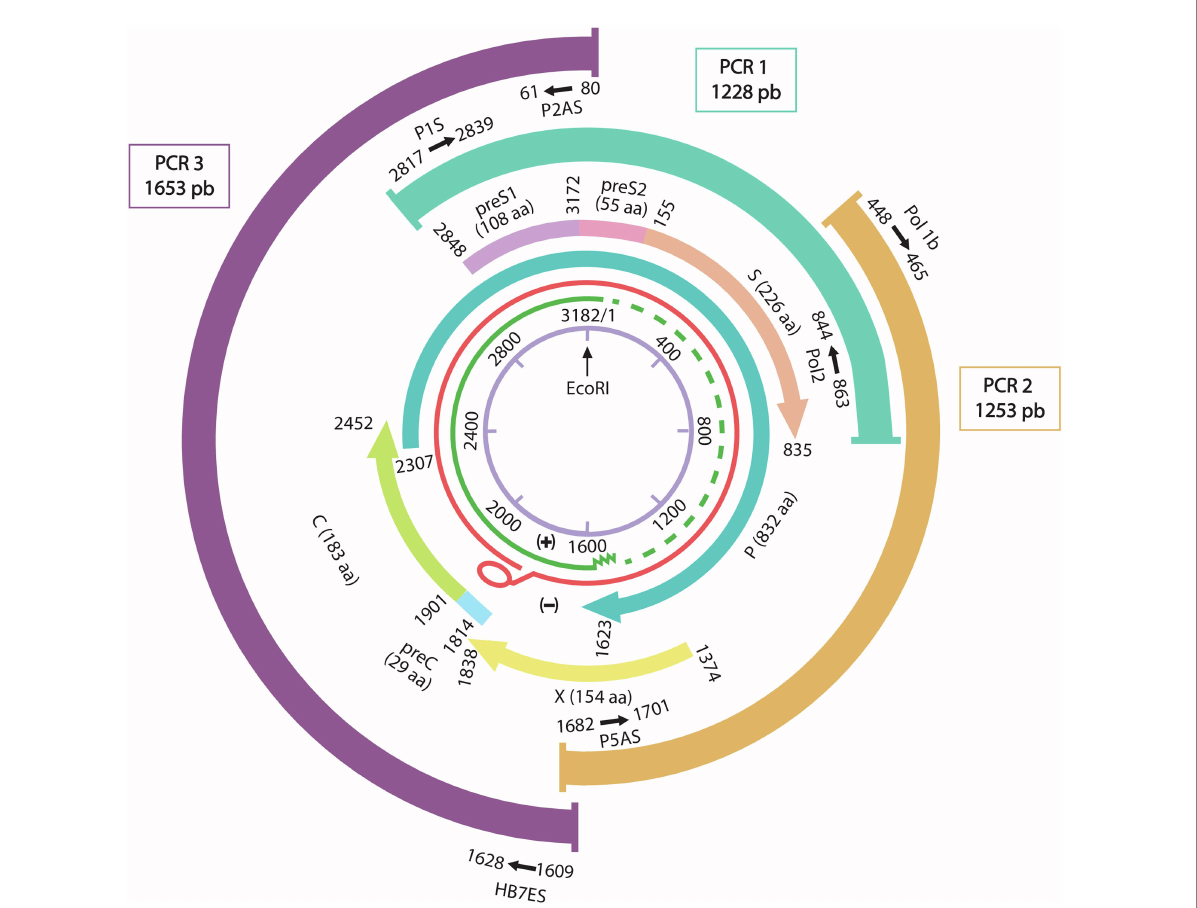
FIGURE 1 Representation of the HBV whole genome with the three overlapping PCR products and their primers sets positions. From inside to outside: schematic representation of the HBV genome with the EcoR1 restriction enzyme site representing nucleotide number 1. In green the incomplete positive strand, in Red the complete negative strand of the HBV genome. The overlapping genes P: Polymerase gene, S: Surface gene, C: capsid gene and X gene. Three overlapping fragments covering the whole genome are represented with the used primers P1S-Pol2 for PCR1 (1,228 nt), Pol1b-P5as for PCR2 (1,253 bp), and P2AS-HB7ES for PCR3 (1,653